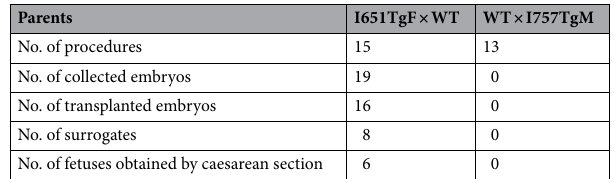
Table 2. Summary of embryo production from F1 transgenic